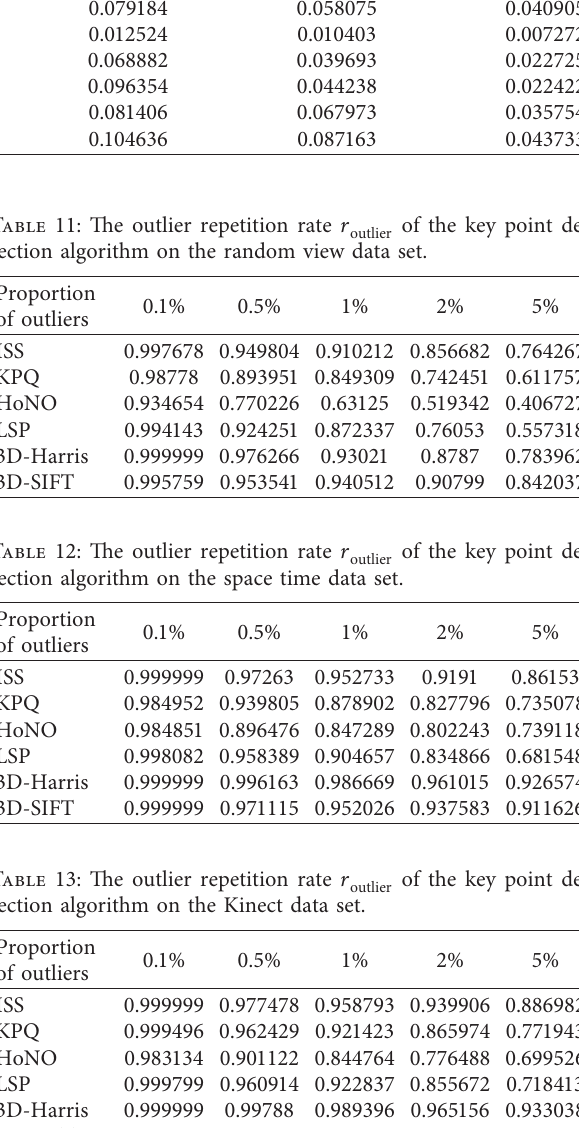
Table 8: The resolution repetition rate r Reduced proportions